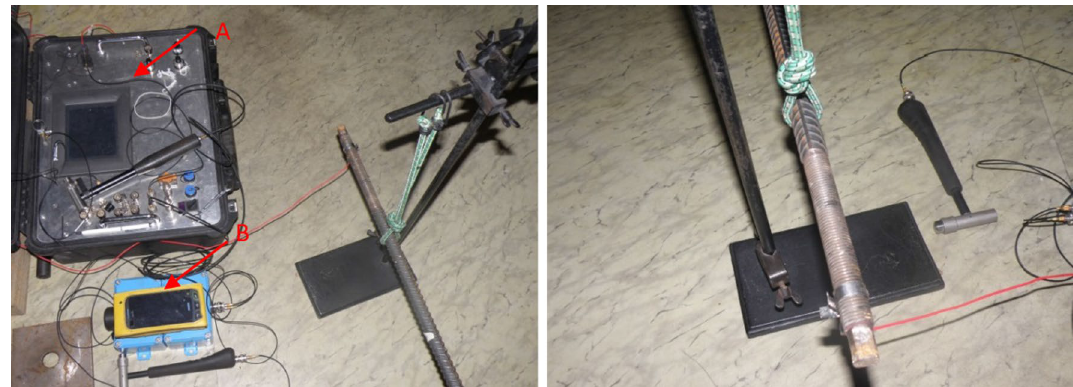
Fig. 7 The validation of the portable measurement system for quality control of installed rock bolts, A—working prototype versus B—final ver- sion fulfilling ATEX requirements Table 2 The identified natural frequencies and damping factors of freely supported rock bolt,